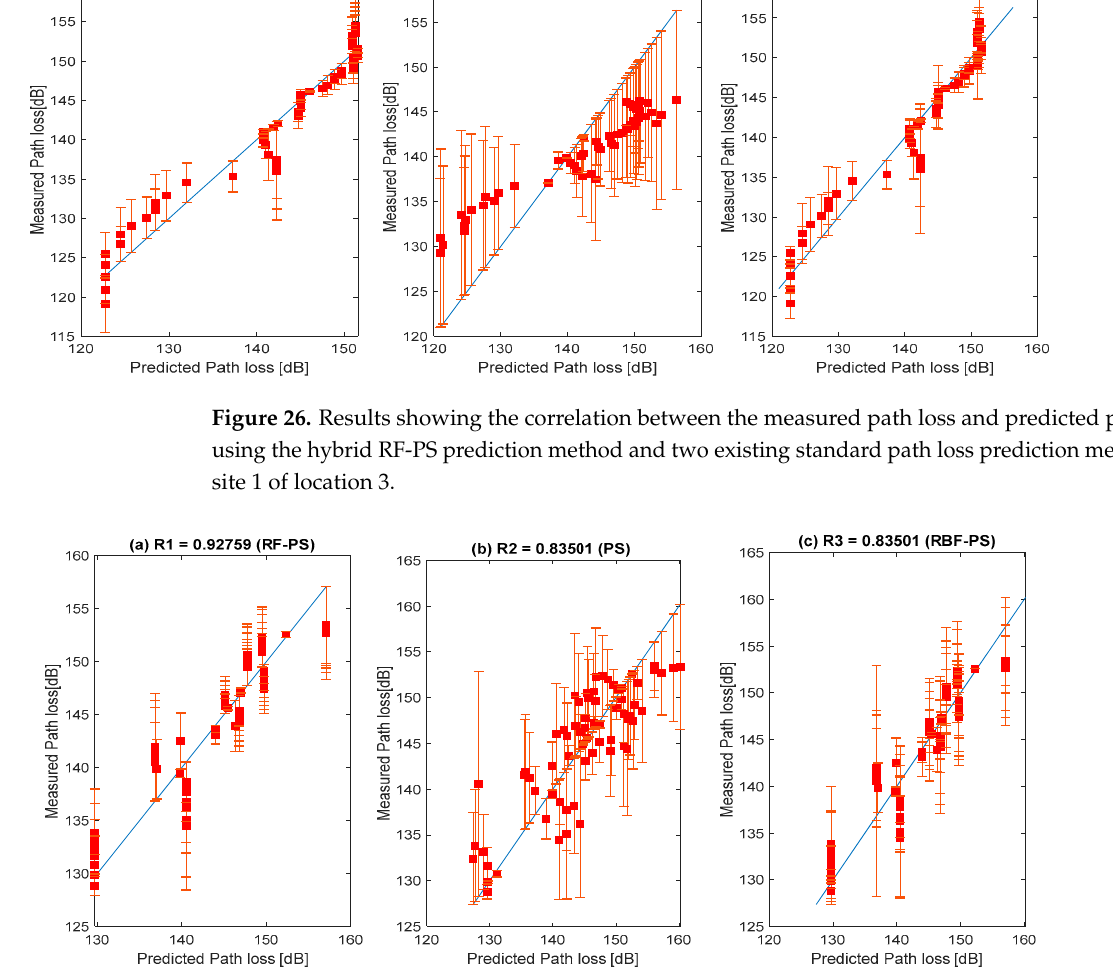
Figure 27. Results showing the correlation between the measured path loss and predicted path loss using the hybrid RF-PS prediction method and two existing standard path loss prediction methods in site 2 of location 3.